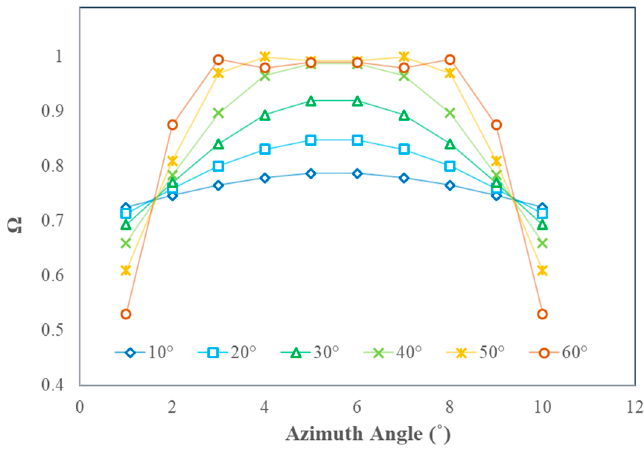
Figure 5. Crop clumping index at specific azimuth angles for different zenith angles (different curves). Other simulation parameters: 1 1